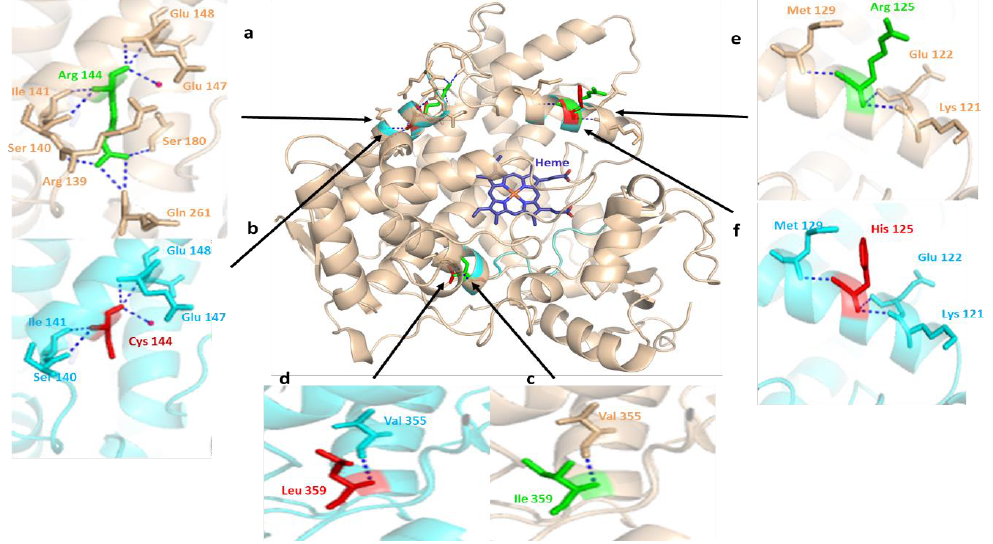
Figure 5. The structural alignment of human CYP2C9 (PDB: 1OG2) to the substrate free mutant CYP2C9 protein obtained by in silico mutagenesis. Hydrogen bonds are represented as a blue dotted line and the water molecule as hot pink spheres. The heme domain is shown in blue, while arrows indicate the deviation sites among the structures of normal (green) and mutated (red) proteins found in the Pakistani population. The wheat colored a, c, and e, and cyan b, d, and f show the 3D representations of normal and altered hydrogen bond interactions corresponding to amino acid changes,